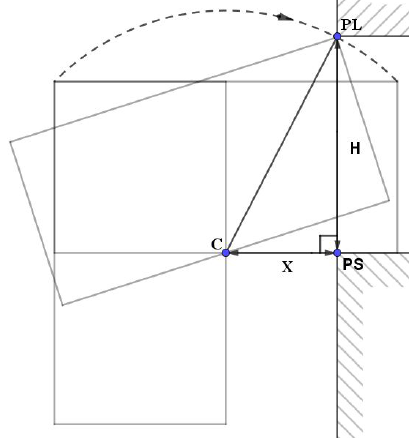
Figure 7. determination of theoretical limit